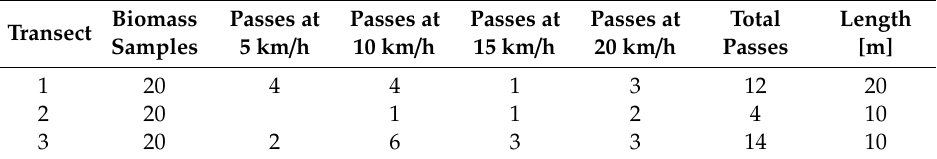
Table 2. Setup of the passes.